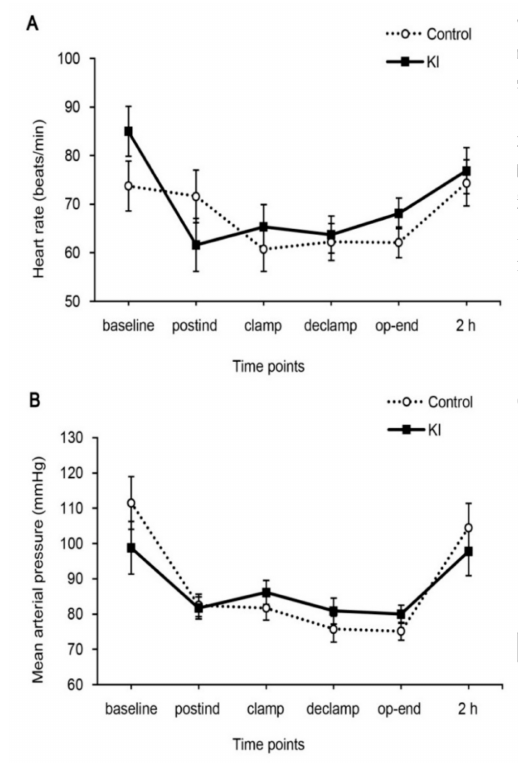
Figure 1. Intraoperative hemodynamics. ( A ) Heart rate and ( B ) mean arterial pressure. Baseline, before induction; postind, 10 min after anesthesia induction; clamp, 10 min before renal artery clamping; declamp, 10 min after renal artery declamping; op-end, end of surgery; 2 h, 2 h after renal artery declamping.